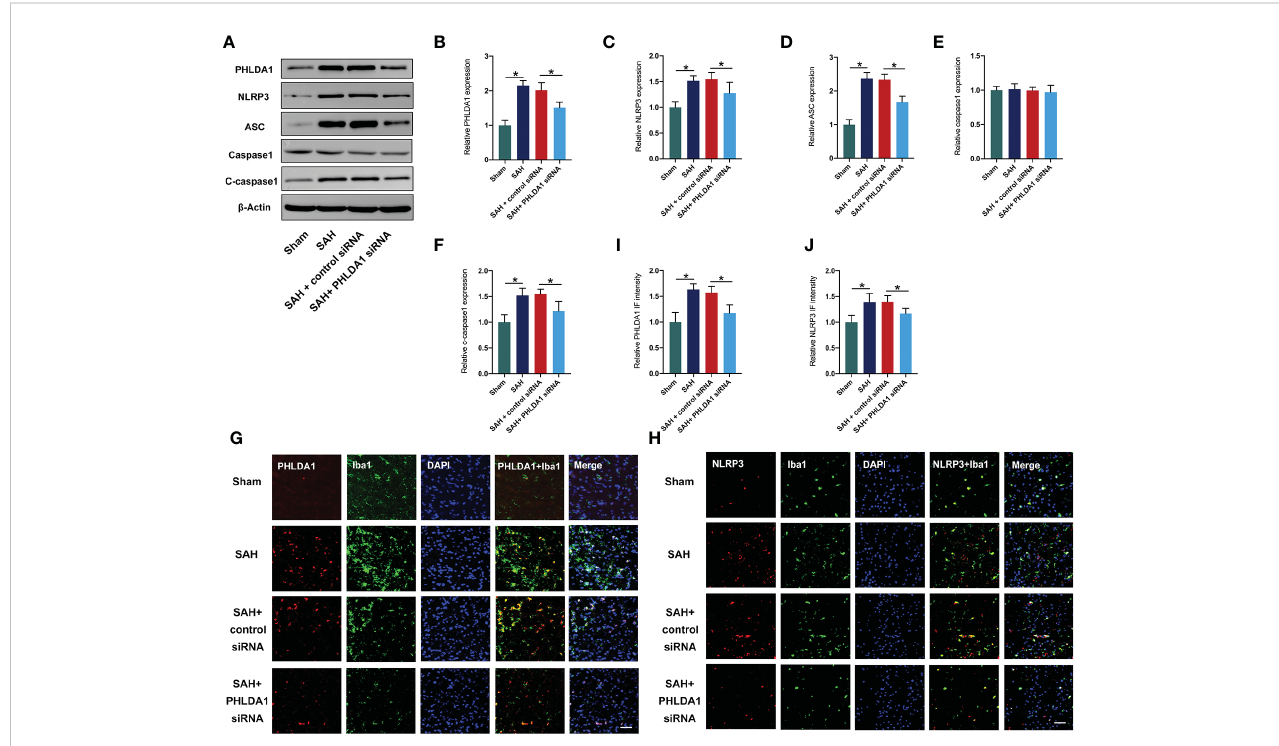
FIGURE 2 PHLDA1 de fi ciency suppressed NLRP3 in fl ammasome signaling after SAH. (A) Representative western blots for PHLDA1, NLRP3, ASC, Caspase1, and Cleaved caspasse1 expressions after SAH. Western blot analysis of PHLDA1 (B) , NLRP3 (C) , ASC (D) , caspase1 (E) , and cleaved caspasse1 (F) expressions after SAH (n = 6 per group). Representative immuno fl uorescence images of PHLDA1 (G) and NLRP3 (H) co-localized with Iba1 in temporal cortex. Quanti fi cation of PHLDA1 (I) and NLRP3 (J) immunoactivities in microglia (n = 6 per group). * P < 0.05. Scale bar=50 m m. Data are expressed as mean ±